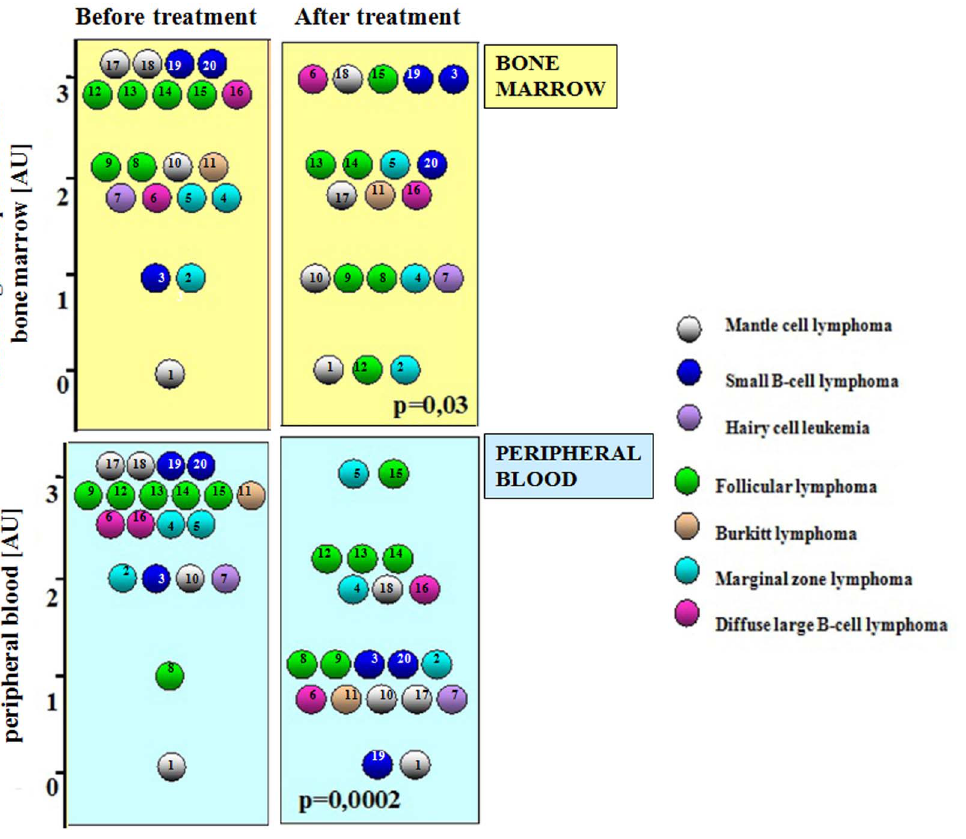
Figure 2. Expression of CXCR4 receptor gene in the bone marrow and blood of NHL patients. Expression before treatment and after treatment (arbitrary units - AU).